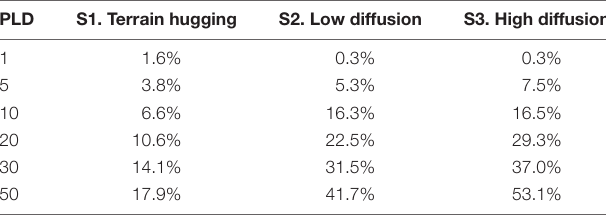
TABLE 2 | The percentage of predicted suitable habitat (after Ross and Howell, 2013) that is overlapped by the dispersal footprint (from Figure 2 ) of each scenario and planktonic larval duration simulated when released from known aggregations.